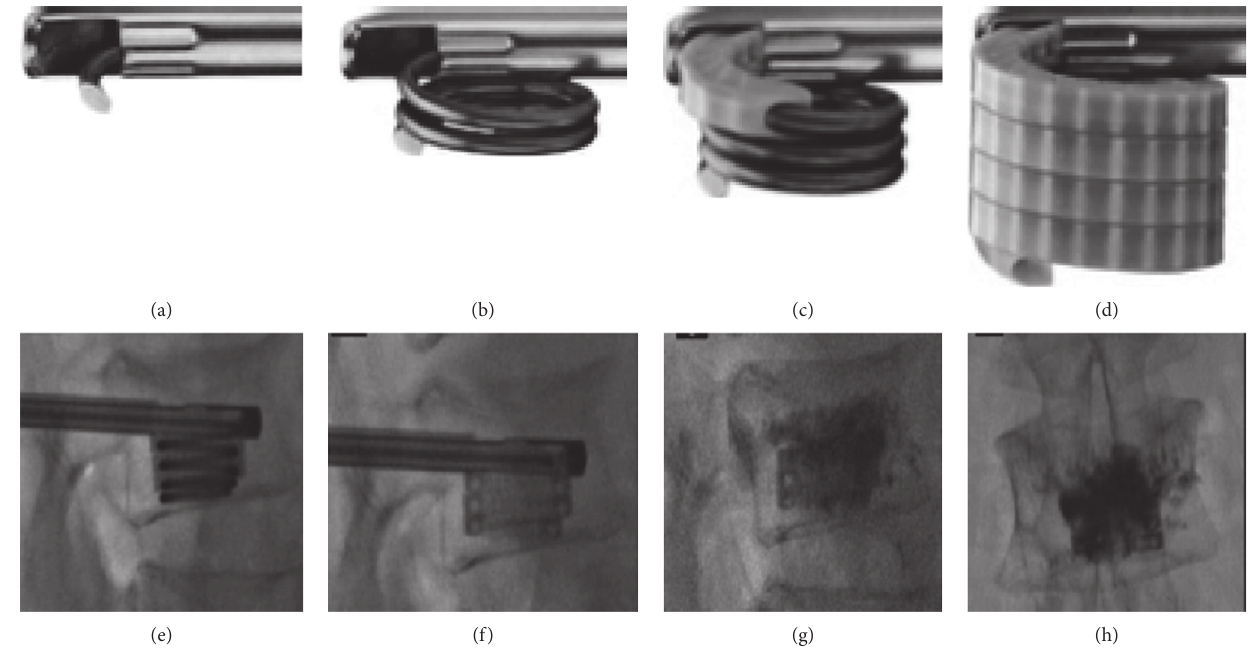
Figure 5: A percutaneous nitinol coil guidewire (a) is coiled within the cancellous portion of the fractured vertebral body. (b) Afterwards, a radiopaque PEEK implant is delivered incrementally via the nitinol coil guidewire (c) and then a nesting, cylindrical column is formed that provides vertical displacement, which may restore the height of the fractured vertebra (d) [10]. Fluoroscopic images illustrating the procedure of using the Kiva VCF treatment system (e). After removing the coil, a radiopaque PEEK implant was implanted (f) to provide structural support to the vertebral body and then bone cement was injected through the implant, as shown by lateral (g) and anteroposterior (h) fluoroscopic images